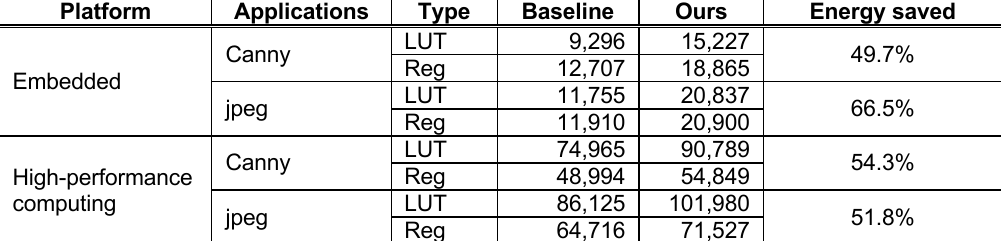
Table 2. Hardwar resources usage for the